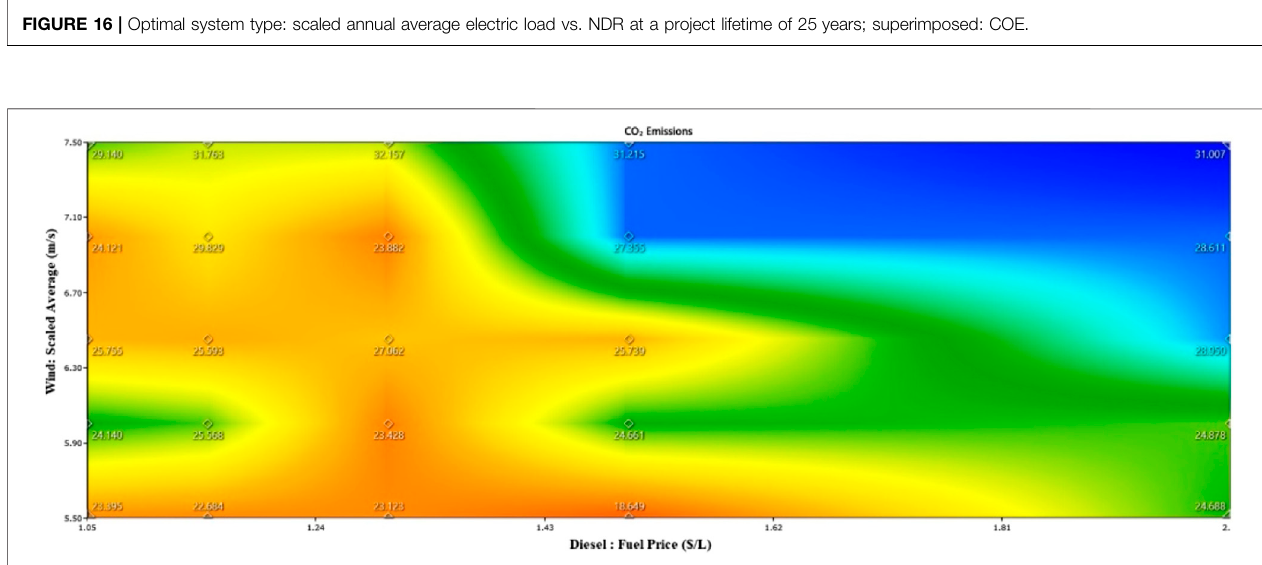
FIGURE 17 | Sensitivity analysis: diesel fuel price vs. wind speed. Surface plot: CO 2 emission; superimposed: % of excess electrical power.